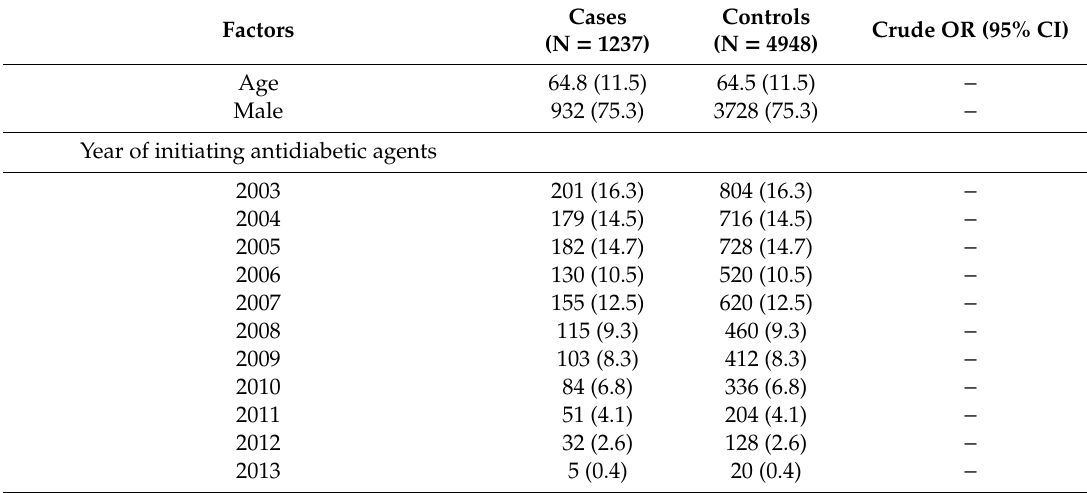
Figure 1. Study flowchart from 2003 to 2013 before and after exclusion of patients with chronic viral hepatitis. Table 1. Hepatocellular carcinoma cases and matched controls among newly diagnosed type 2 diabetes patients without chronic viral hepatitis prescribed any antidiabetic agents.